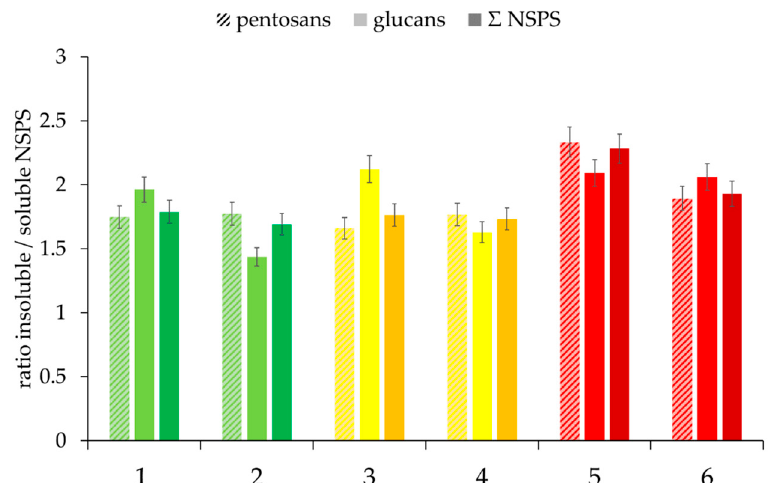
Figure 4. Ratio of insoluble-to-soluble NSPS of the selected rye flour samples, depending on “good” to “medium” to “poor” baking quality and the corresponding falling number (FN) within the individual classes (here: first samples were always assigned the lower FN and second samples the higher FN). Sample description: see Table 1. Bars represent the mean value of two replicates; error bars represent the confidence interval.